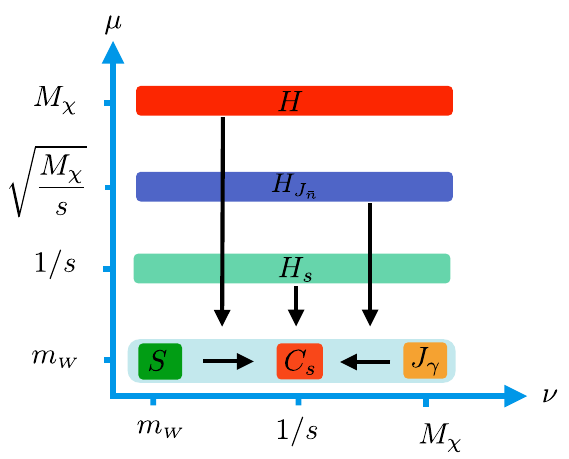
Figure 7 . The RG path used to resum logarithms. The non-cusp term of the one-loop rapidity anomalous dimension vanishes, so that this path remains valid at NLL